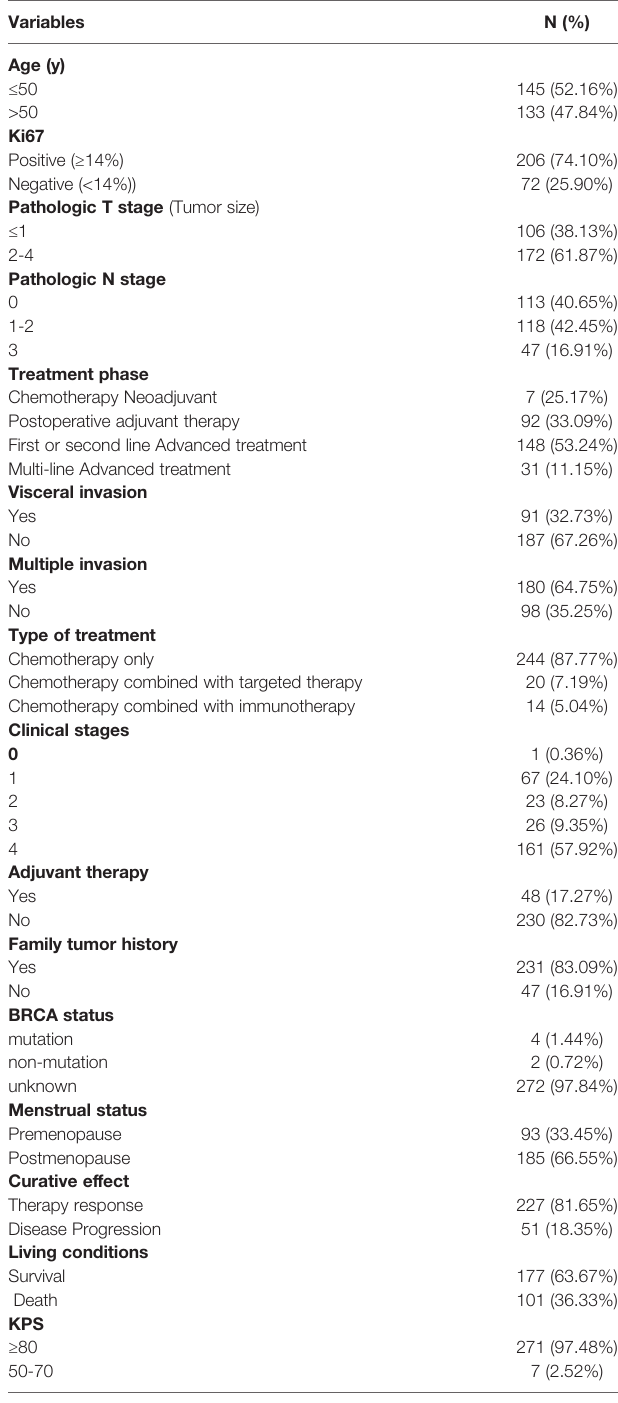
TABLE 1 | Main baseline clinicopathological characteristics of the study population (N=278).